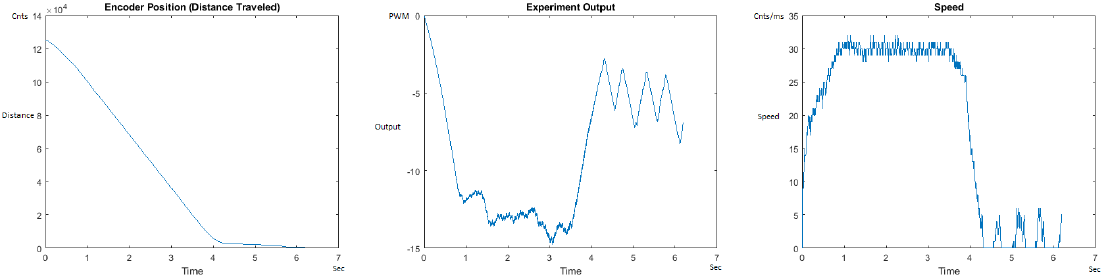
Figure 28. Encoder position, output and speed plots for PID++ DOWN operation— Vmax 30 cnts/ms, Adesired 0.055 cnts/ms 2 —1 Kg.